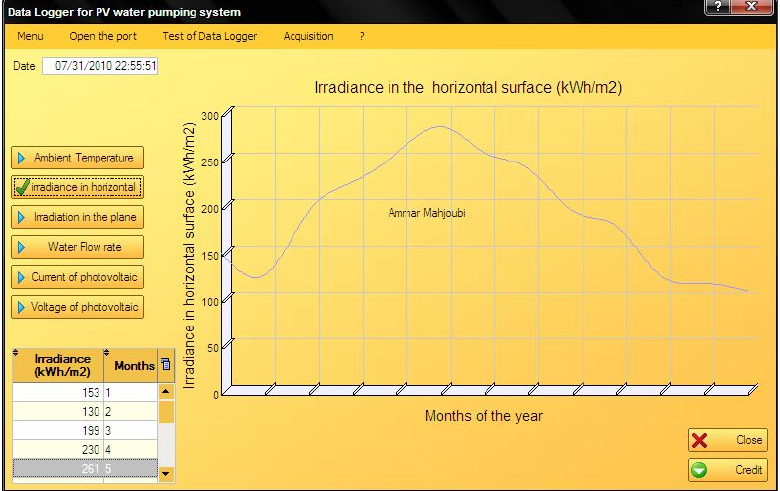
Figure 21. Variation of mean horizontal surface monthly irradiance of the year 2009 for